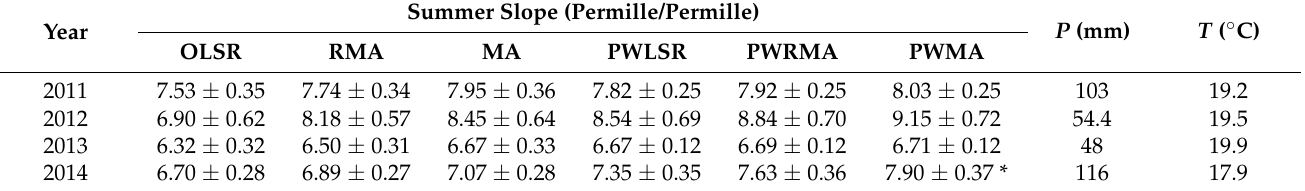
Table 3. Inter-annual variation of the slope of the δ D– δ 18 O linear relationship (in permille/permille) using the six regression methods, precipitation amount ( P in mm) and surface temperature ( T in ◦ C) based on event-based samples at Anning in summer from 2011 to 2014. Summer Slope (Permille/Permille) P Year